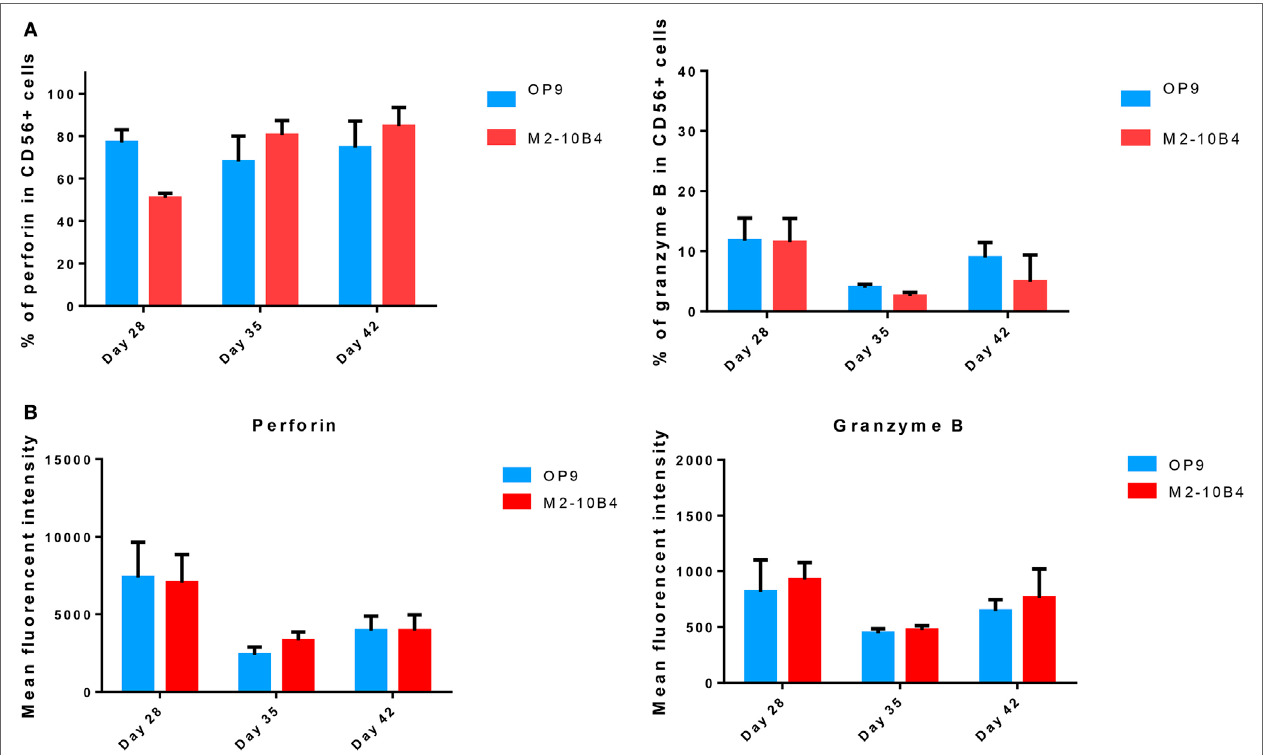
FigUre 3 | (a) Percentage of CD56 + natural killer (NK) cells expressing perforin and granzyme B cultured with OP9 and M2-10B4 feeder cells at days 28, 35, and 42 of the differentiation protocol. (B) Mean fluorescence intensity of perforin and granzyme B of CD56 + NK cells generated in the presence of OP9 and M2-10B4 feeder cells at days 28, 35, and 42 of differentiation. p -Value: * p < 0.05, ** p < 0.005, and *** p < 0.001. The absence of any asterisk indication means there are no significant